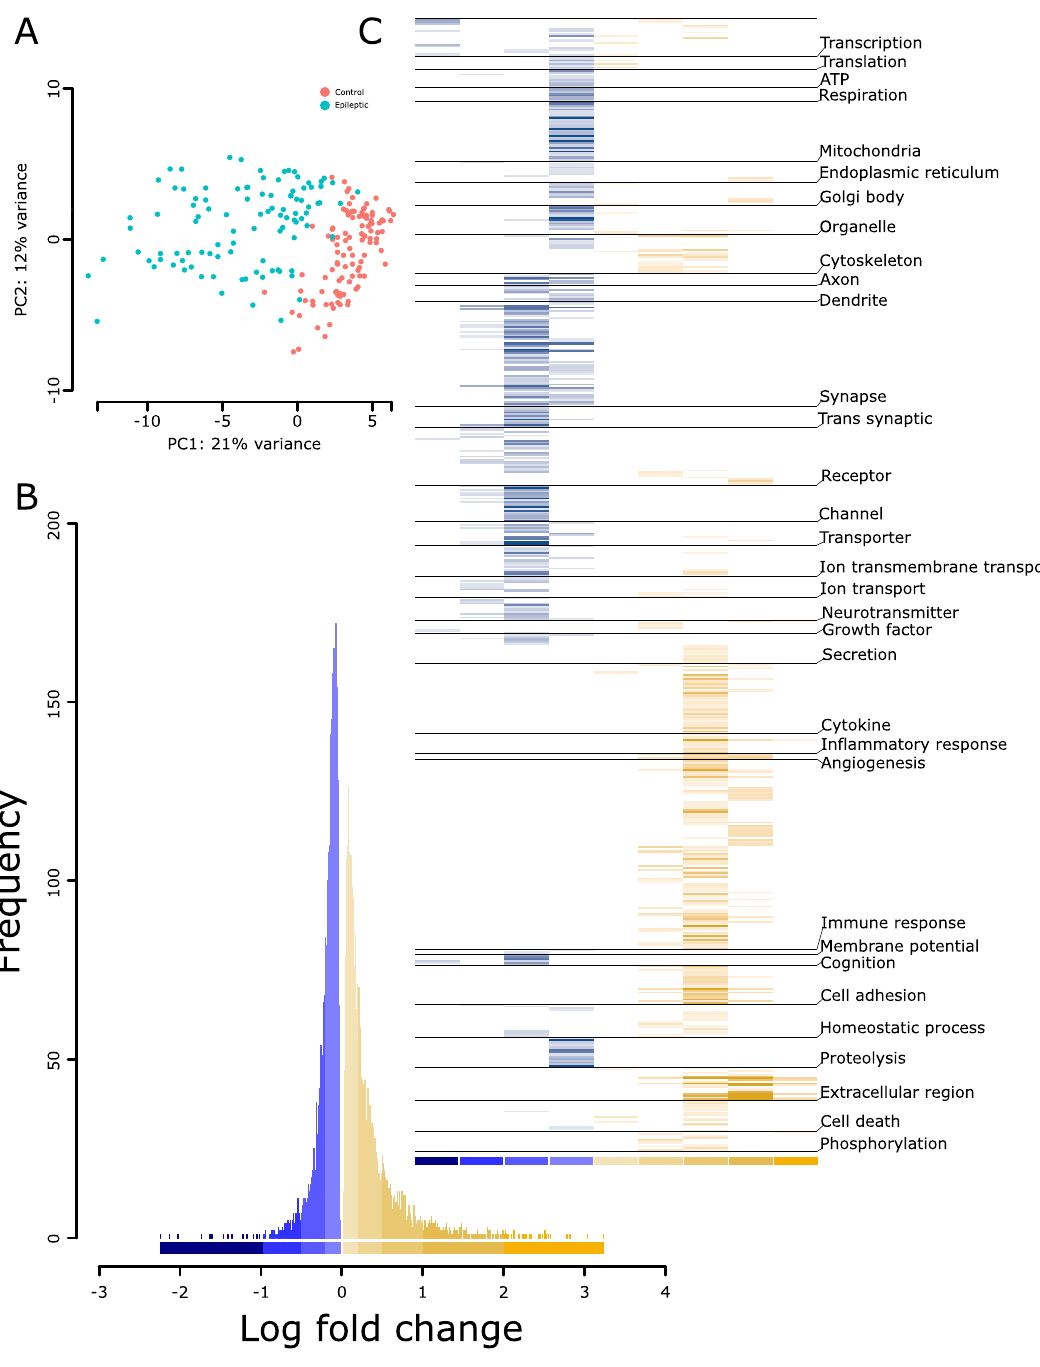
Figure 1. Distinct transcriptomics and pathway profiles of pilocarpine induced TLE in mice. ( A ) Principal components analysis segregating the transcriptomics profile of the control and pilocarpine induced TLE mice. ( B ) Frequency of differentially expressed genes binned based on log-fold changes across down- (blue) and up- (yellow) regulated genes. See Table S1 for genes under each bin. ( C ) Pathway profiles of up- and downregulated genes by log-fold change bin (from B ) using Gene Ontology. The − log 10 (q value) of each pathway was used to plot the heatmap. The lighter-to-darker shades of blue and yellow indicate increasing significance of down- and upregulated pathways, respectively. See Table S2 for the pathways grouped under each